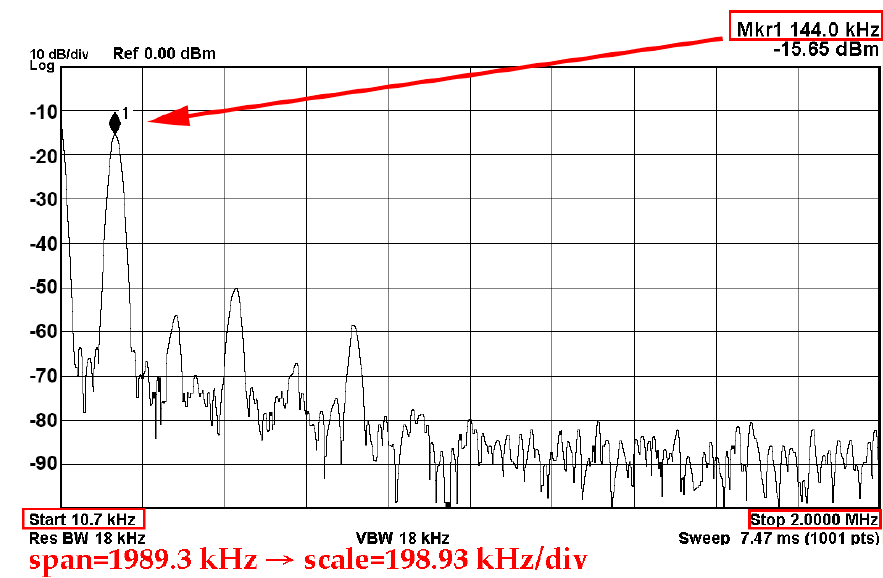
Figure 20. The experimental BP frequency spectrum analysis of Figure 19.